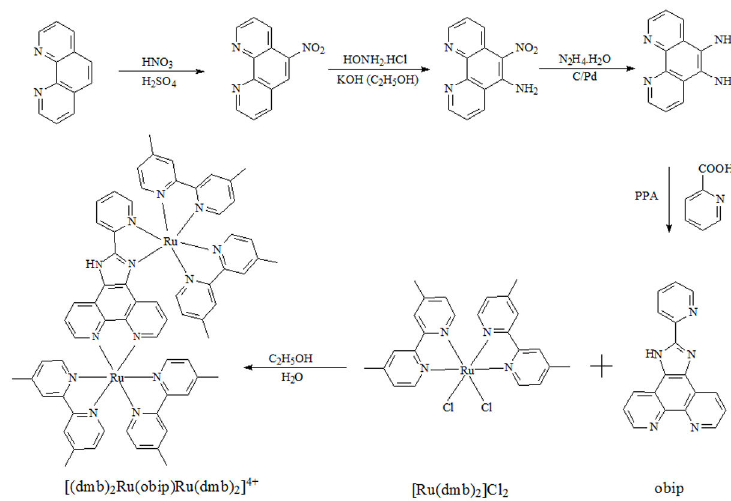
Ru(obip)Ru(dmb) ] 4+ . 2 2